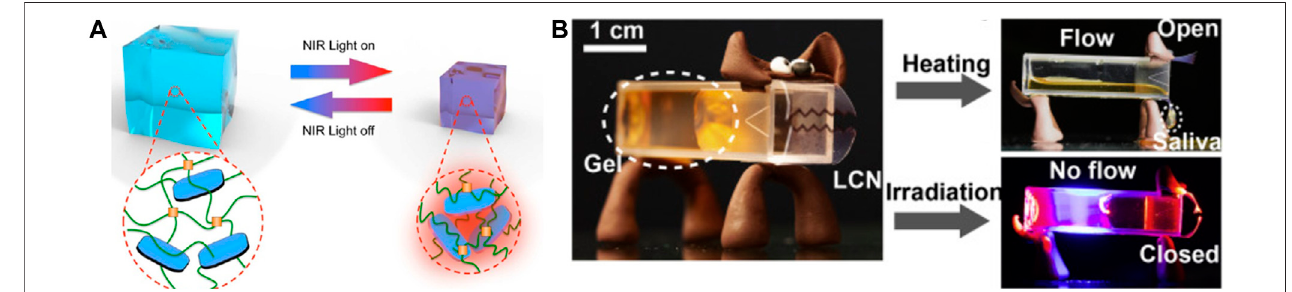
FIGURE 2 | (A) Reversible contraction of PNIPAM/GO nanocomposite hydrogels actuator responds to IR light stimulation. Reproduced from Shi et al. (2015) with permission of American Chemical Society. (B) Side view of the original dog after incubation at 50 ° C for 27 min, showing salivation (gel dripping). Reproduced from Zeng et al. (2020) with permission of